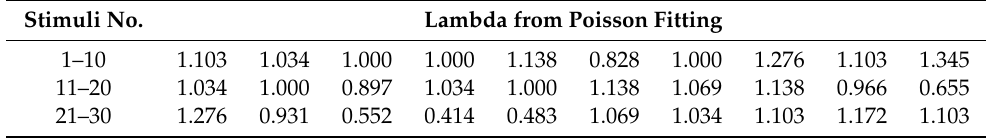
Table 2. The estimated number of anxiety moments for each video with anxiety events. Stimuli No.